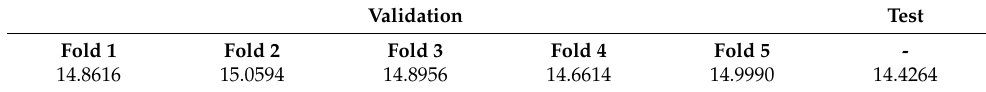
Figure 4. Accuracy history of the model during training. The blue line shows the mean absolute error of the entire training set, while the yellow is the test accuracy used for validation purposes. Notice test accuracy starts to stagnate approximately 40 epochs in, indicating that further training from this point has negligible effects.